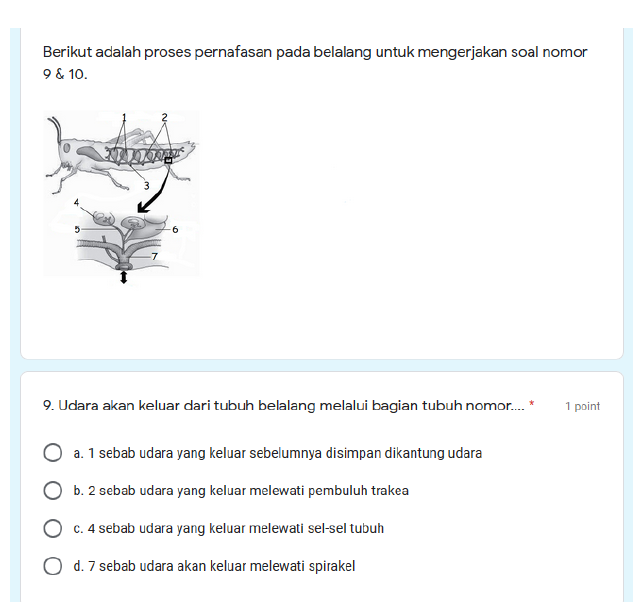
Figure 14. Logic and reasoning question number 9, package